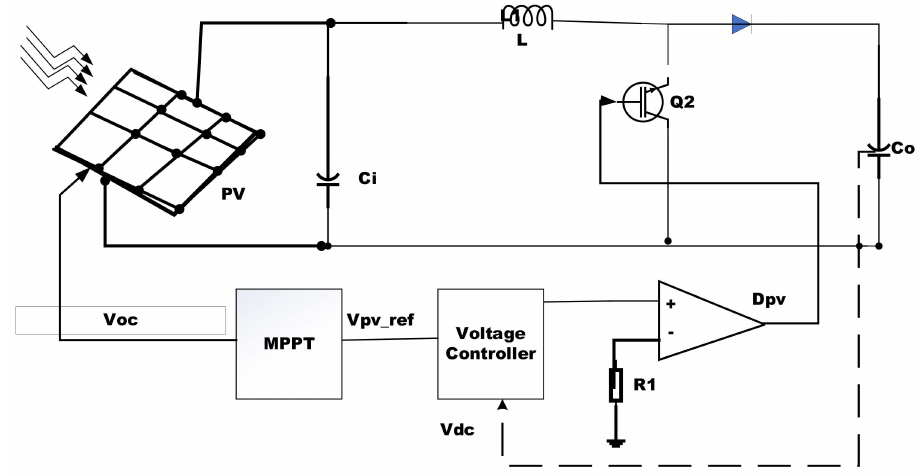
Figure 4. MPPT control strategies.